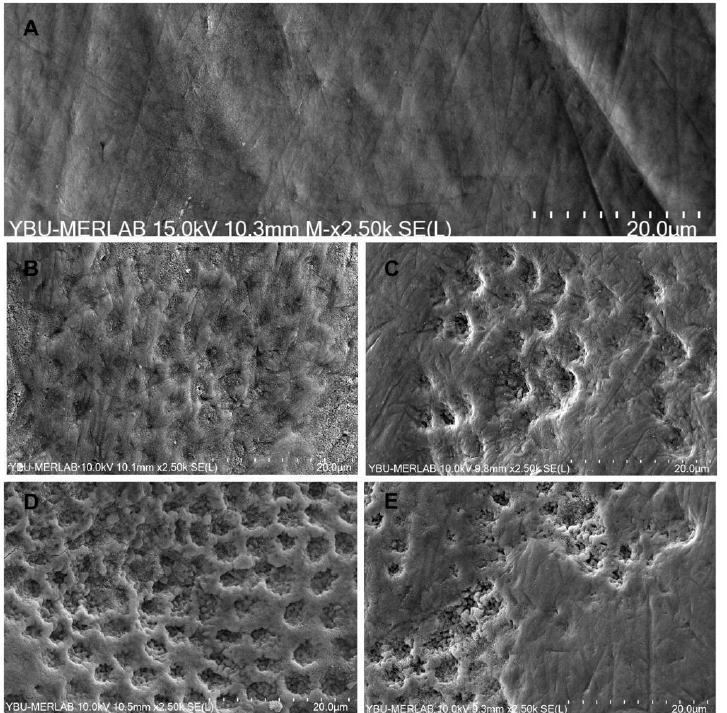
Figure 2. Scanning electron microscopy photographs of enamel surfaces before and after the application of bleaching gels with different HP concentrations: ( A ) no bleaching (control); ( B ) bleaching with 40% HP + F; ( C ) bleaching with 35% HP + Ca; ( D ) bleaching with 25% HP + nHA; ( E ) bleaching with 18% HP + nHA.